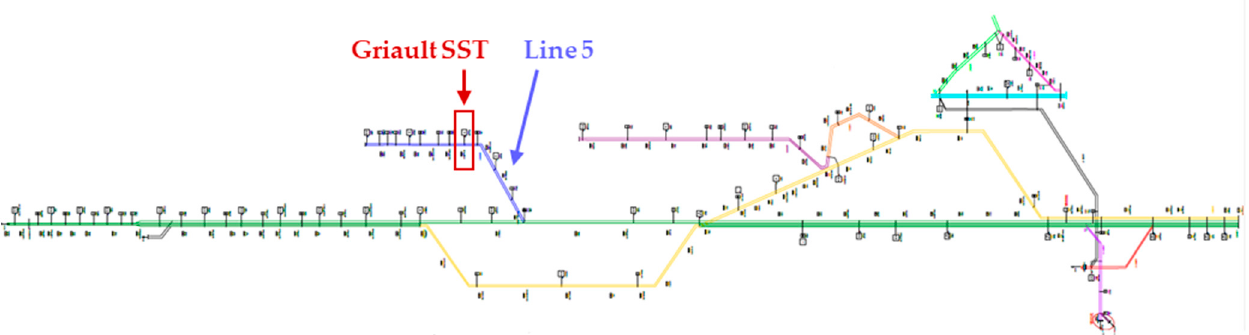
Figure 14. Topology and electric configuration of the test case. Each color corresponds to a train line. The red square locates the default substation.